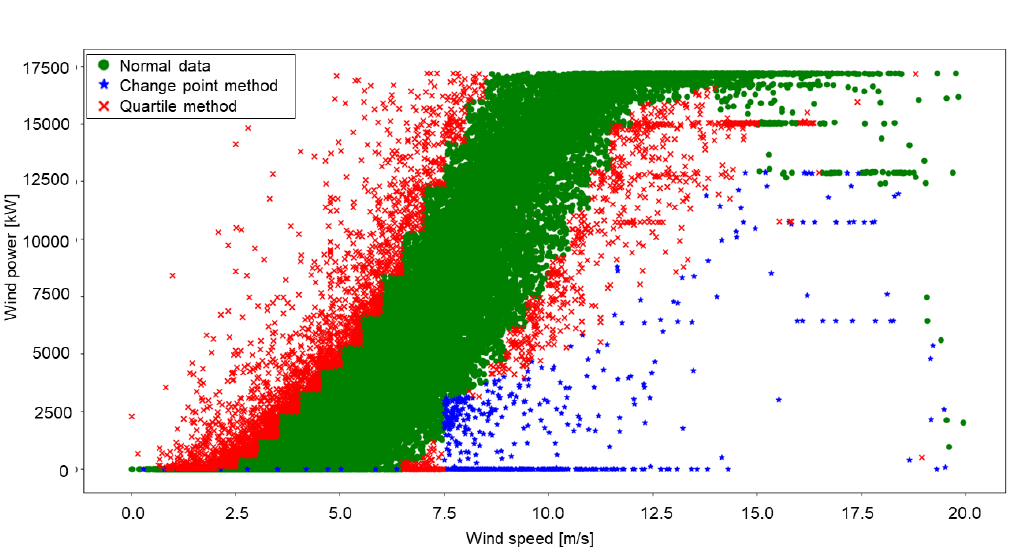
Figure 4. Abnormal wind power data filtering on the E-Cloud data, according to the procedure exposed in [38]. Normal points are tagged with green circles, and abnormal points are tagged with blue stars (red crosses) if they have been identified using the change point method (quartile